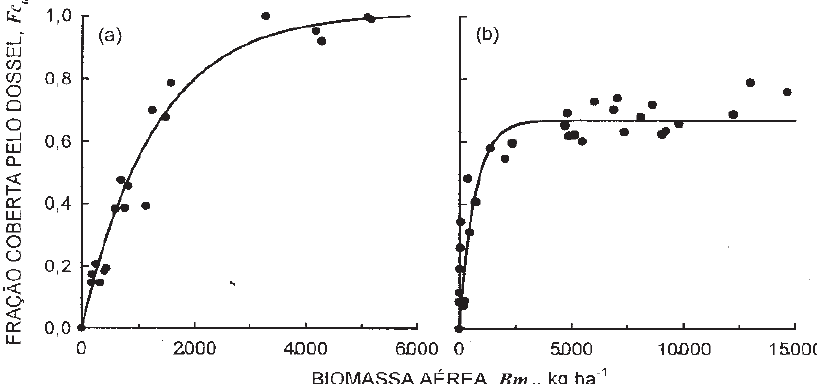
Figura 2. Relação entre a biomassa, aérea e a fração coberta pelo dossel, para as culturas do feijão (a) e do milho (b). A linha tracejada representa a equação [9] ajustada para os pontos